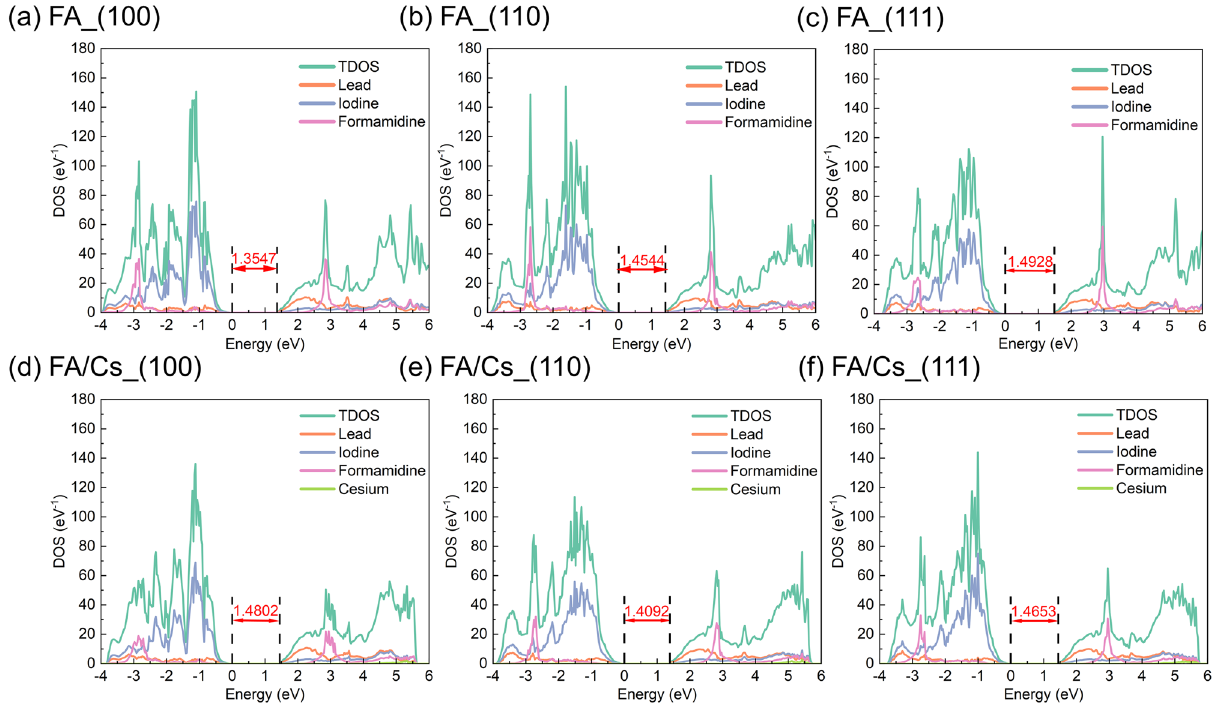
Figure 6. Total density of state (TDOS) and projected density of state (PDOS): ( a – c ) FAPbI 3 with different FA cations orientation: ( a ) (100), ( b ) (110), ( c ) (111); ( d – f ) FA 0.875 Cs 0.125 PbI 3 with different FA cations orientation: ( d ) (100), ( e ) (110), ( f )